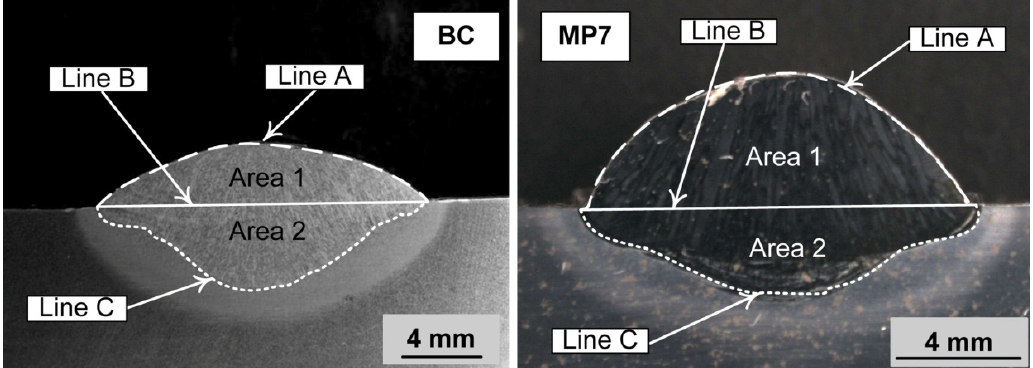
Figure 2. Weld metal cross-section micrographs via stereoscope.